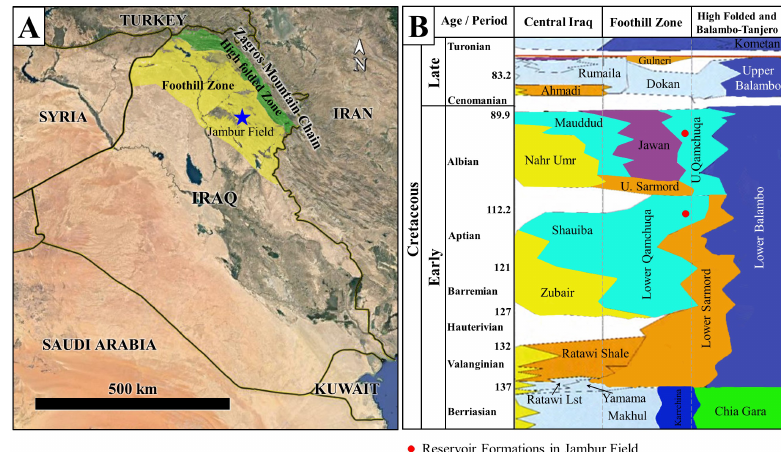
Figure 10. ( A ) Map of Iraq showing the location of Jambur field indicated by a blue star; ( B ) Sequence stratigraphy of the Cretaceous Age, highlighting the producing formation in Jambur field indicated by red dots within the foothill zone, modified after